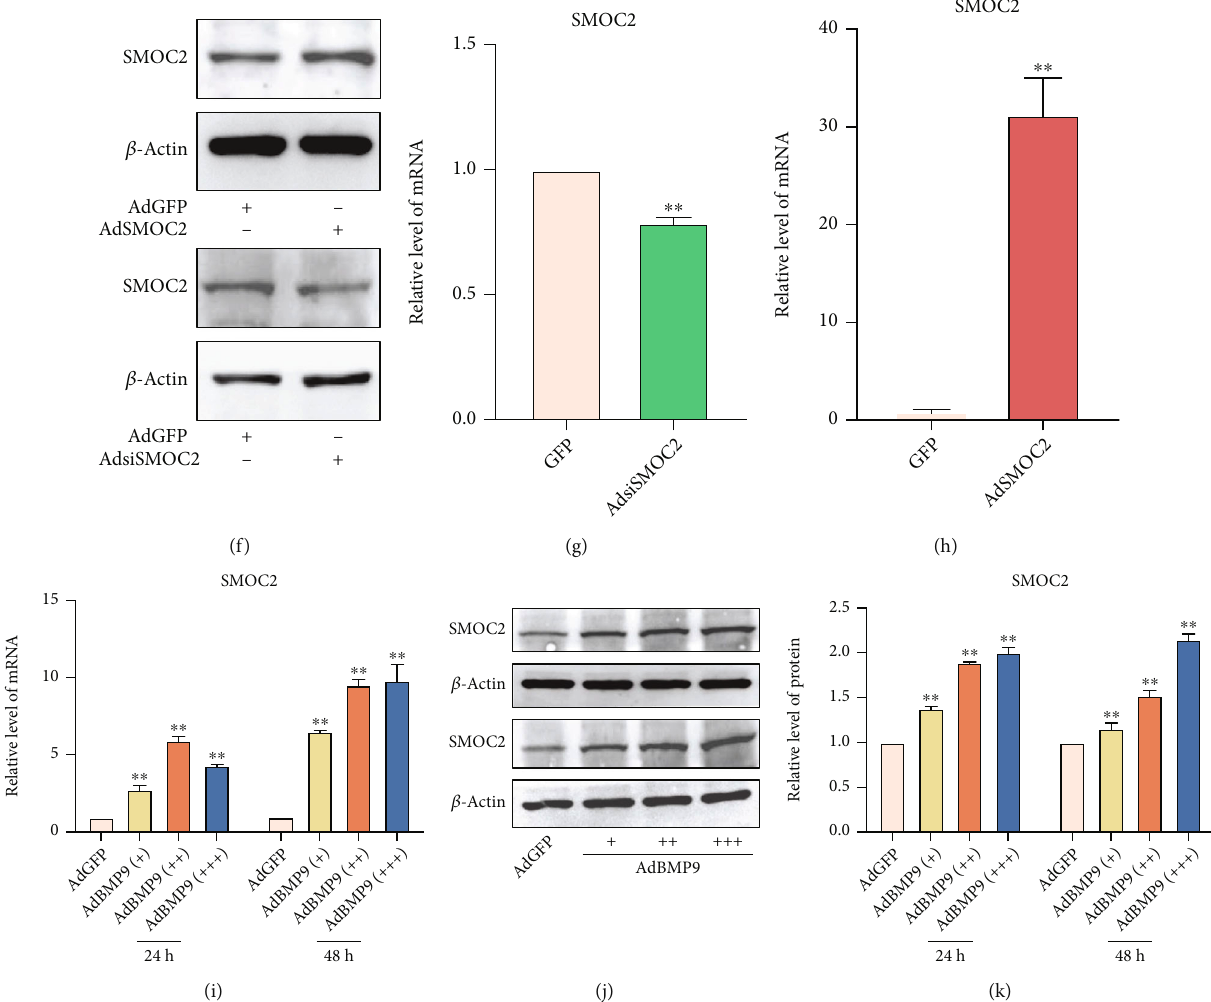
Figure 1: BMP9 upregulates the expression of SMOC2 in MSCs. (a) Heatmap of the top 10 upregulated and downregulated mRNAs between the control (AdGFP) and experimental groups (AdBMP9). (b) RNA-seq analysis showed the expression value of s moc2 between AdGFP and AdBMP9. (c) Real-time PCR assay results showed endogenous mRNA expression of s moc2 in mesenchymal progenitor cells. (d) Western blot assay results showed endogenous protein expression in mesenchymal progenitor cells; β -actin was used as an internal reference. (e) E ffi cient transduction of MEFs by the recombinant adenoviruses (AdGFP, AdBMP9, AdSMOC2, and AdsiSMOC2) at 24 h. The expression of the marker genes monomeric RFP and GFP was detected at 24h after infection in both bright and fl uorescence fi elds. (f – h) Western blot and real-time PCR assays showed the expression of SMOC2 in MEFs at 24 h after infection by recombinant adenoviruses overexpressing SMOC2 and knocking down SMOC2. (i) Real-time PCR assay results showed the e ff ect of BMP9 on mRNA expression of s moc2 in MEFs ( ∗ p < 0 : 05 , ∗∗ p < 0 : 01 vs. control). (j) Western blot assays showed the e ff ect of BMP9 on SMOC2 protein expression in MEFs. (k) The quanti fi cation results of the Western blot assay showed the e ff ect of BMP9 on the protein expression of SMOC2 in MEFs ( ∗ p < 0 : 05 , ∗∗ p < 0 : 01 vs.